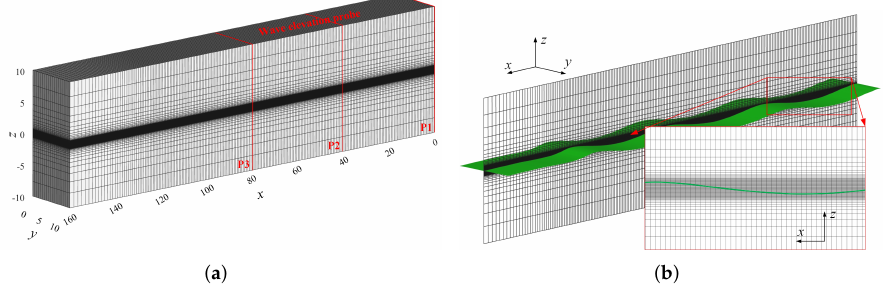
Figure 3. Computational grid of regular and unidirectional wave cases: ( a ) domain grid and position of wave elevation probe; ( b ) local refined grid near the air-water interface, green surface and curve showing the desired wave.